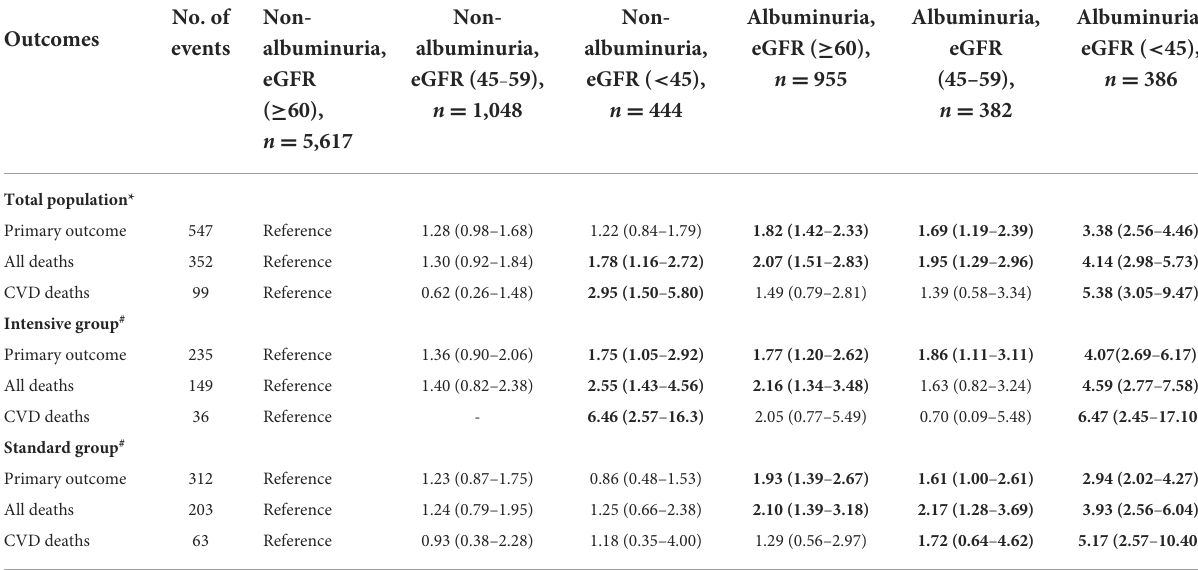
TABLE 2 Risk of Primary outcomes and total and cardiovascular mortality by baseline CKD and albuminuria status.